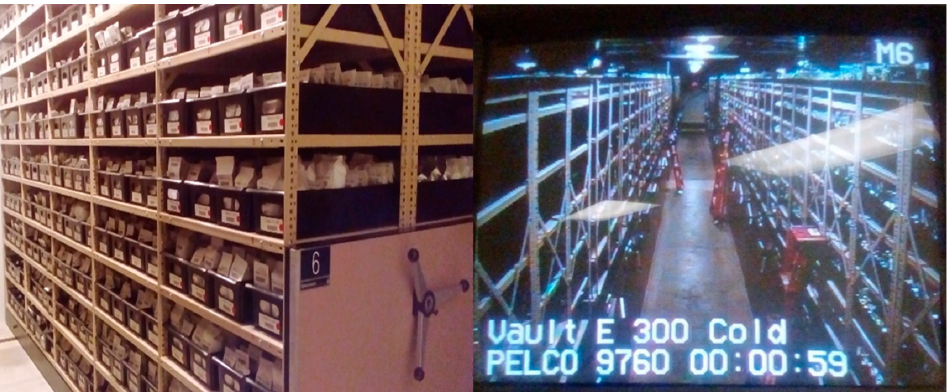
Figure 8. Seed vaults for long-term storage at the United States Department of Agriculture—Agricultural Research Service genebank in Fort Collins, Colorado.